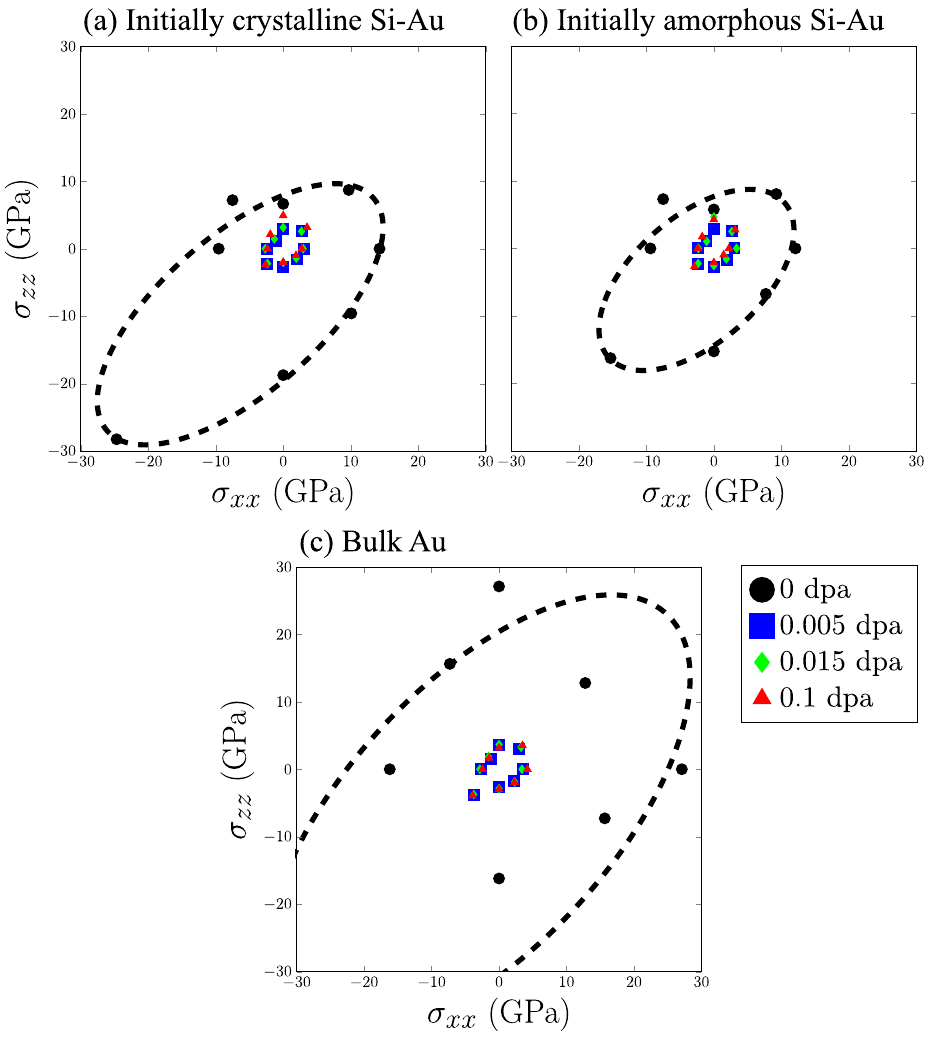
Figure 5. Yield surfaces for ( a ) Initially-crystalline Si–Au, ( b ) Initially amorphous Si–Au, and ( c ) Bulk Au. σ xx represents lateral stress. σ zz represents interfacial normal stress. Biaxial compression yield point of 0dpa bulk Au 66.02 GPa is located at σ xx = σ zz = −